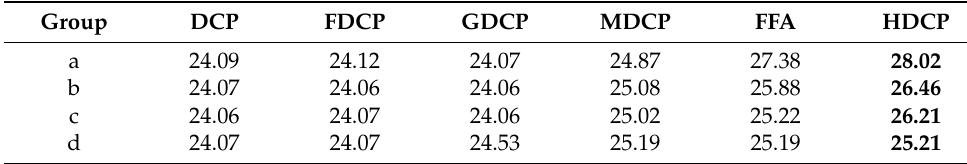
Table 2. PSNR of different algorithms.